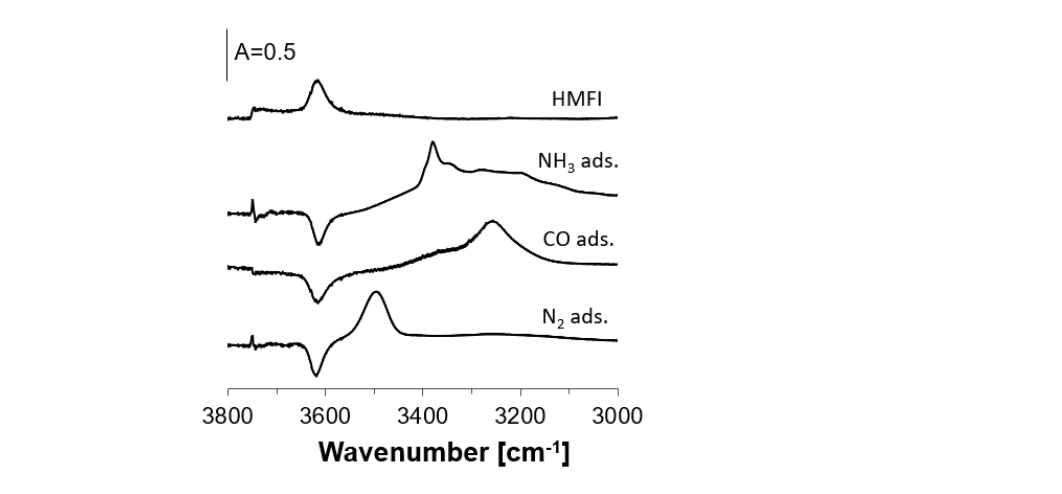
Figure 2. IR spectra of OH groups in zeolite HMFI and MFI with adsorbed ammonia, CO, and N 2 . All the spectra were recorded at 170 K.